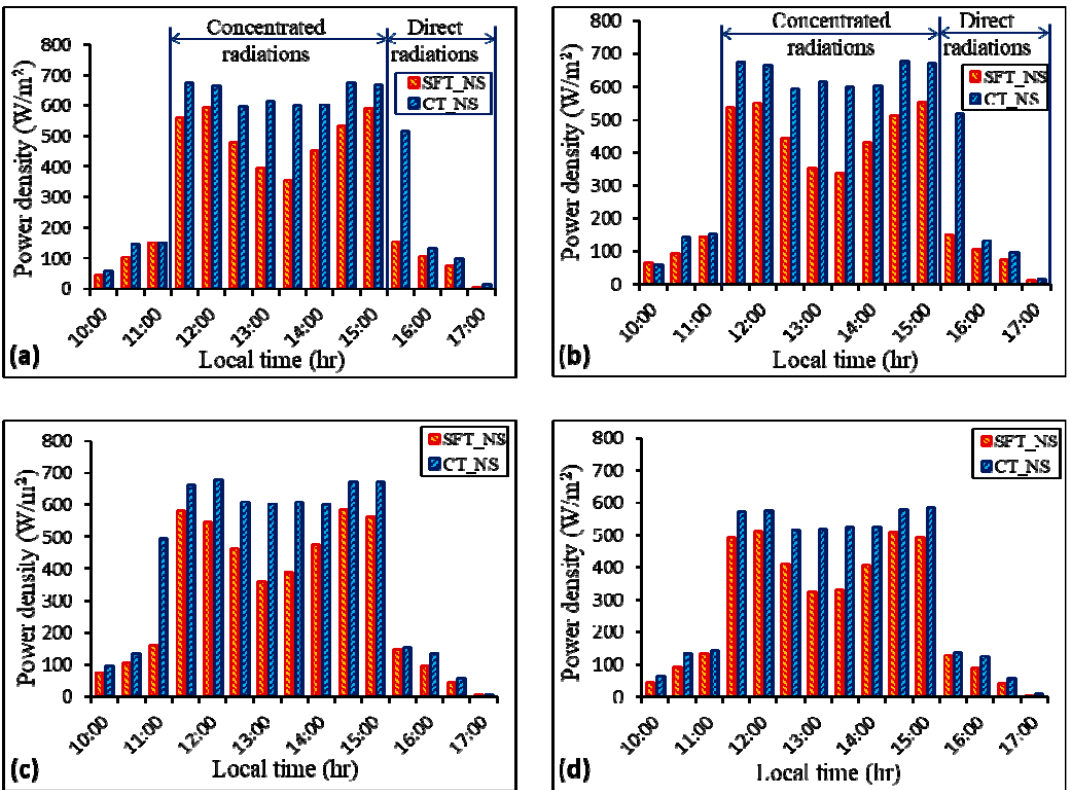
Figure 10. The optical power density for N-S oriented CPC collector integrated with SFT and CT receivers at: ( a ) spring equinox (20th Mar); ( b ) summer solstice (21st Jun); ( c ) autumn equinox (23rd receivers at: ( a ) spring equinox (20 th Mar); ( b ) summer solstice (21 st Jun); ( c ) autumn equinox (23 rd Sep) Sep) and ( d ) winter solstice (21st and ( d ) winter solstice (21 st Dec).